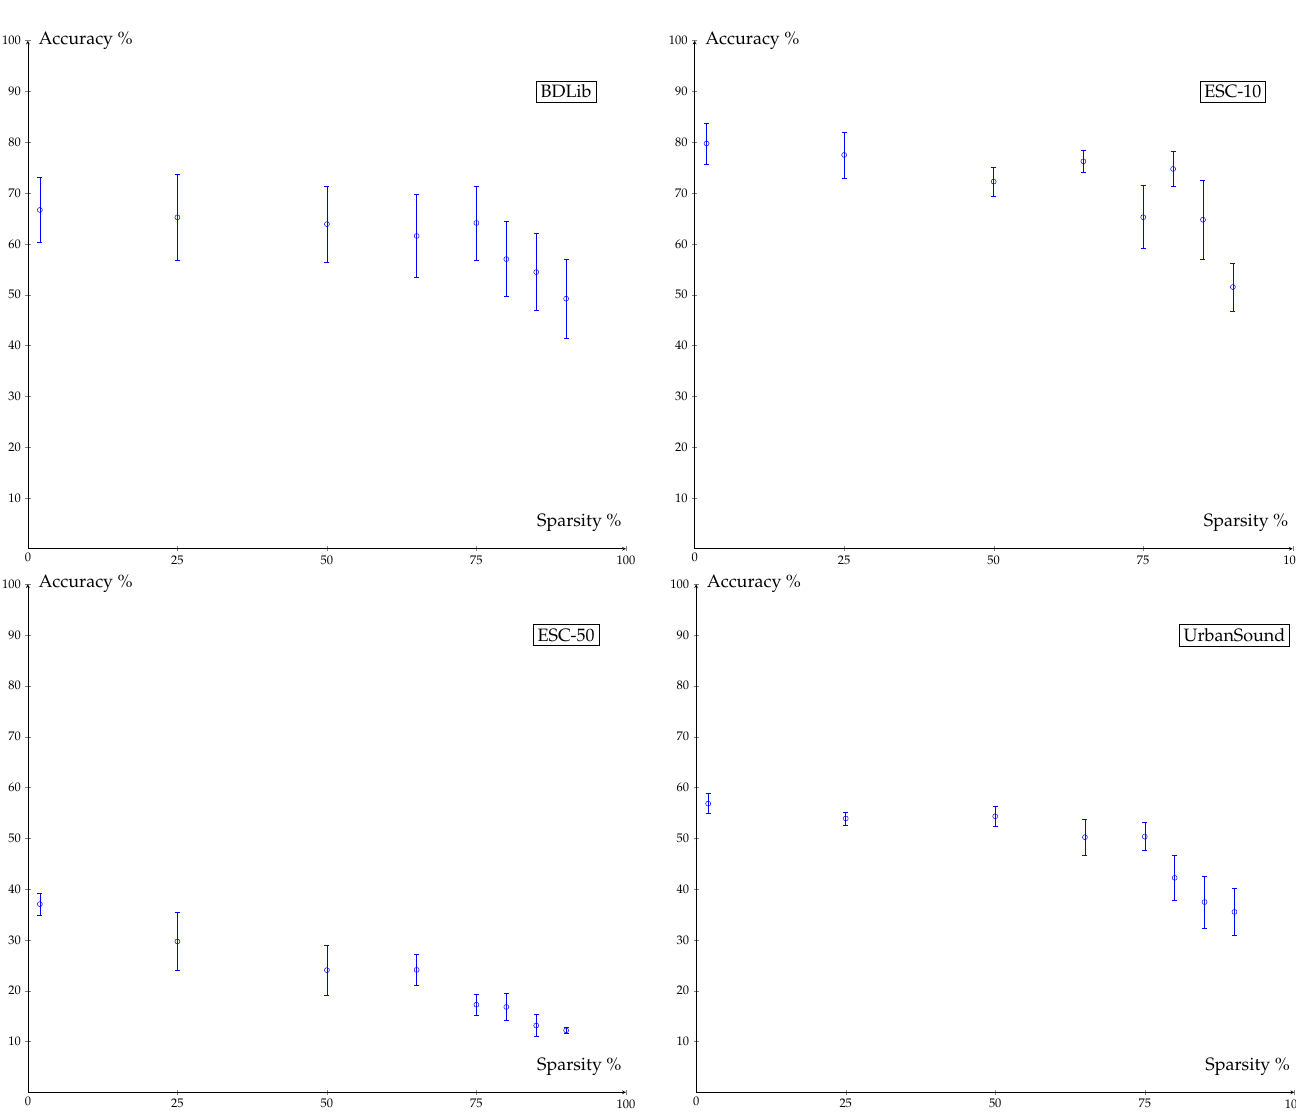
Figure 9. Accuracy of the (trained) models for different levels of sparsity. Only a small degradation in accuracy can be observed up to 75% sparsity. Above 75% sparsity, the accuracy drops